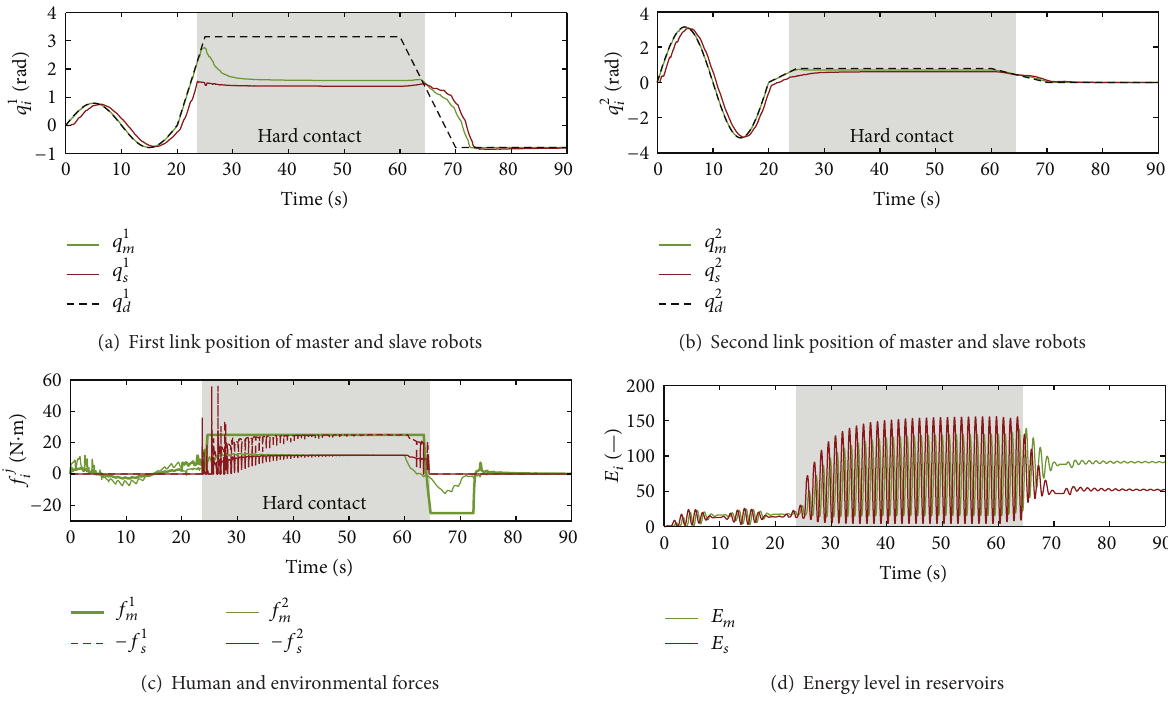
Figure 6: System response for 𝐵 𝑚,𝑠 (𝑡) ∈ [10, 250] .